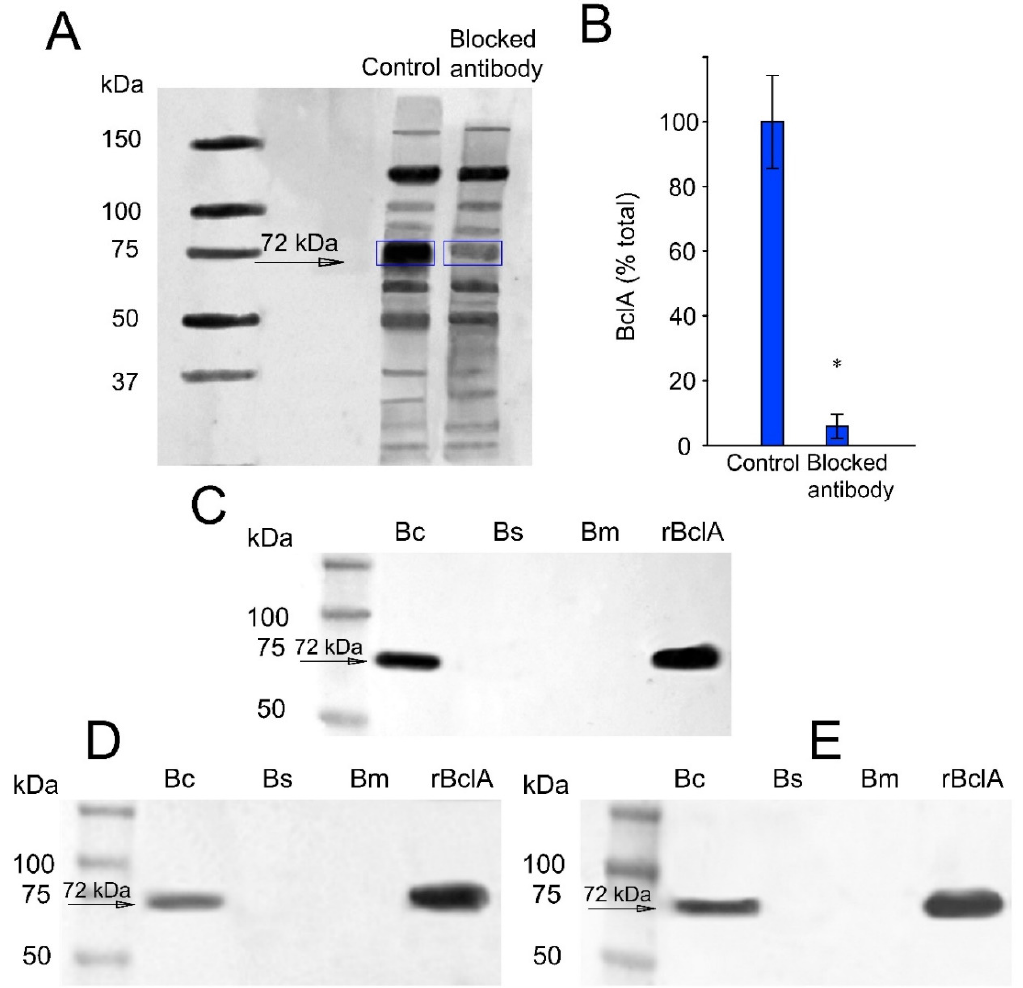
Figure 1. Western blot analysis of antibody interactions with spore coat proteins. ( A ) Competitive paratope inhibition of BclA, using pAb1 (anti- B. cereus + B. subtilis spores). ( B ) The immunoblot in panel A was quantified by densitometry. Values were normalized to the total concentration of protein per lane. ( C ) Selectivity of the mAb2 (anti- B. anthracis spores) and binding affinity for isolated rBclA from E. coli and two other Bacillus species. ( D ) Selectivity of the hamster rAb (rAb3-anti-BclA) toward spore lysate from various Bacillus species. ( E ) Selectivity of the llama rAb (rAb4-anti-BclA) with spore lysates from different Bacillus species. Wells contained ~25 µ g protein lysate and ~20 ng purified rBclA. Panel B: error bars represent standard deviations from three separate experiments. The asterisk indicates a statistically significant difference ( t -test) between unblocked and blocked pAb (* p < 0.005). Abbreviations: Bc, Bacillus cereus ; Bm, Bacillus megaterium ; Bs, Bacillus subtilis